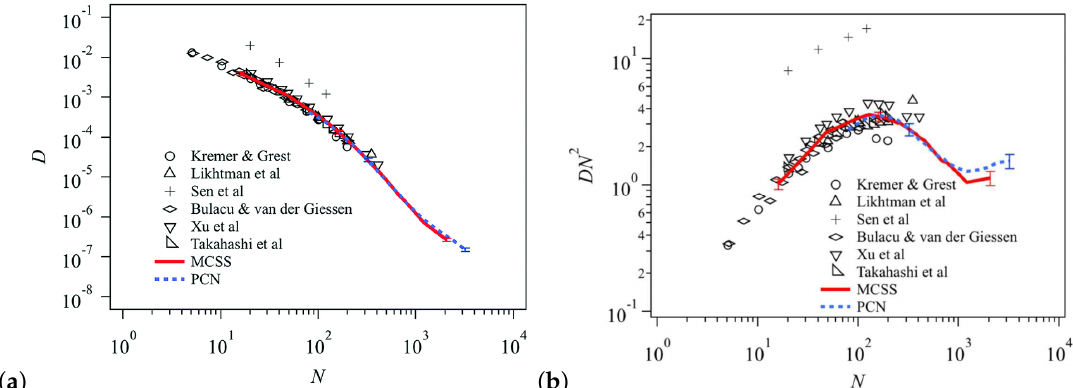
Figure 13. ( a ) Center-of-mass diffusion coefficient and ( b ) its normalized value with respect to the classical reptation behavior (bottom) plotted against the number of beads per chain, N . Red solid and blue dotted curves are the results of multi-chain slip-spring (MCSS) and primitive chain network (PCN). The MCSS and PCN data are rescaled by the scale-conversion factors. KG results obtained from the literature [26,96,111,187–189] are shown by symbols. Error bar shows the standard deviation for 8 independent simulation runs. Reproduced from [190] with permission from the Royal Society of